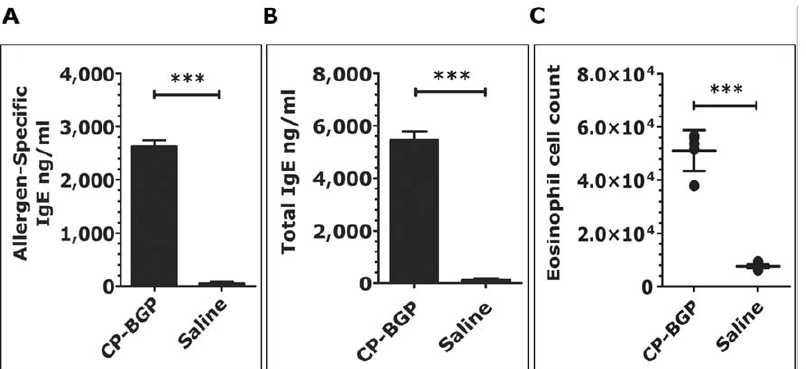
Figure 8. Intranasal administration of CP BPG enhances the allergen-specific IgE and total IgE Abs response. Four weeks after the initial intranasal sensitization mice were bled. Allergen-specific IgE ( A ), total IgE ( B ) levels in sera from CP-BGP or saline C57BL/6 mice were measured by ELISA. Individual serum samples were measured and expressed as the geometric means 6 SEM (n=5 per group). ( C ) Increased eosinophil influx into nasal mucosa of C57BL/6 mice sensitized intranasally with CP-BGP. Cell counts were determined by differential FACS staining of cells isolated from the nasal mucosa. Data is shown as mean 6 SD (n=5 per group). Significant differences (*** p , 0.001 compared with paired control group. One representative experiment of two is